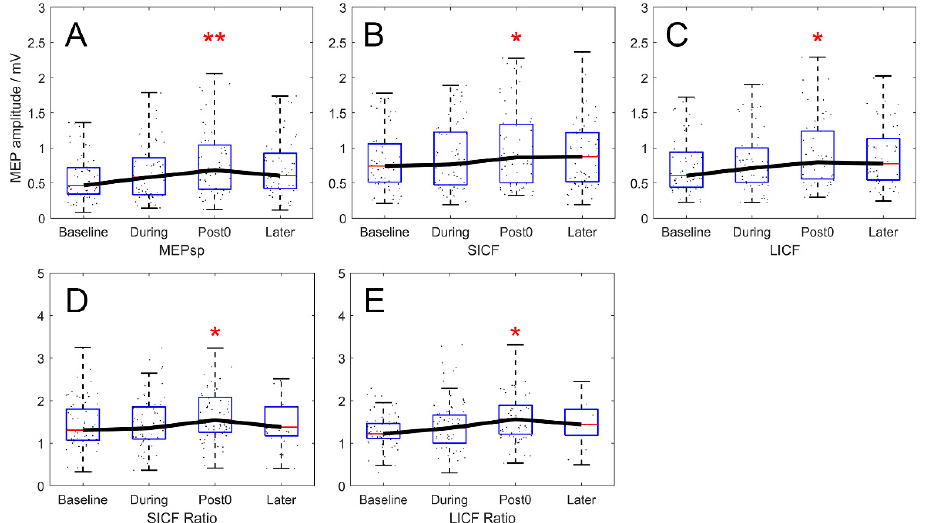
Figure 2. Chronological modulation of MEP sp , SICF and LICF in rest condition (real ‐ rTMS group). ( A – C ) Outcomes expressed in MEP amplitude (mV). MEP amplitude of rest MEP sp , MEP SICF and MEP LICF increased significantly at the Post timepoint, compared to Baseline. ( D , E ) Outcomes expressed in ICF ratio normalized by baseline MEP sp amplitude. Normalized SICF and LICF ratio also showed significant enhancement at the Post timepoint compared to Baseline. Boxes denote 25th and 75th percentile values, whiskers denote minimum and maximum values. Asterisks denote significant difference compared to the Baseline timepoint. * p < 0.05; ** p < 0.01. After normalisation, along with the significant effect of TIME (F 3,217 = 2.803 and 2.985;